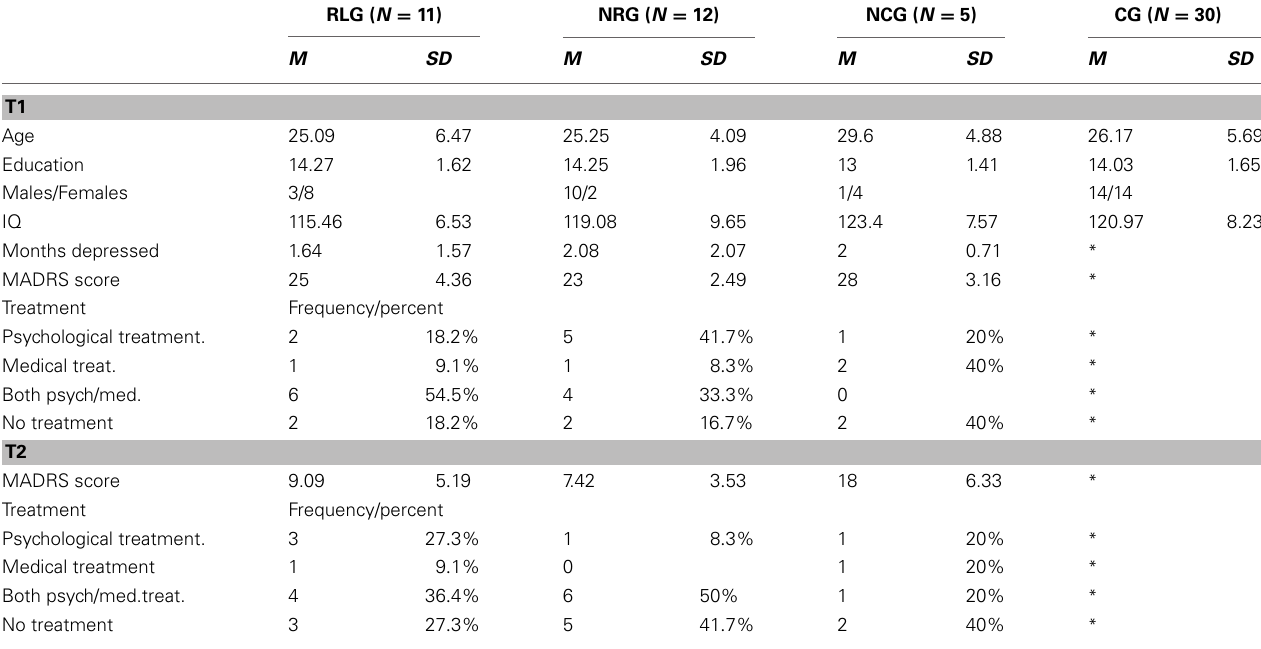
Table 2 | Descriptive data for the relapse group (RLG), the no relapse group (NRG), the no change group (NCG), and the control group (CG) at T1 and